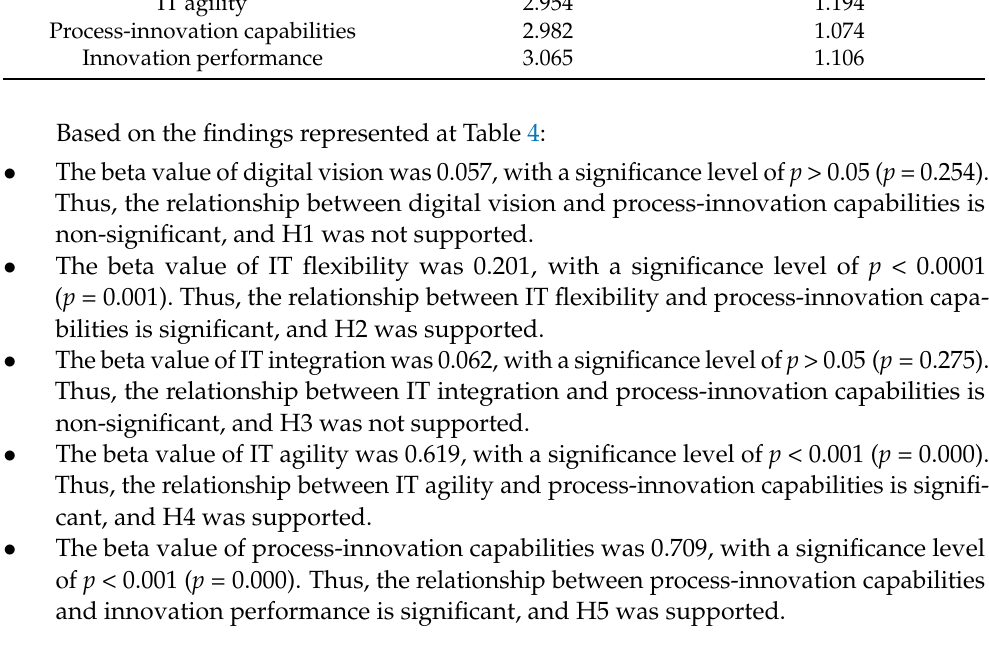
Table 4. Regression